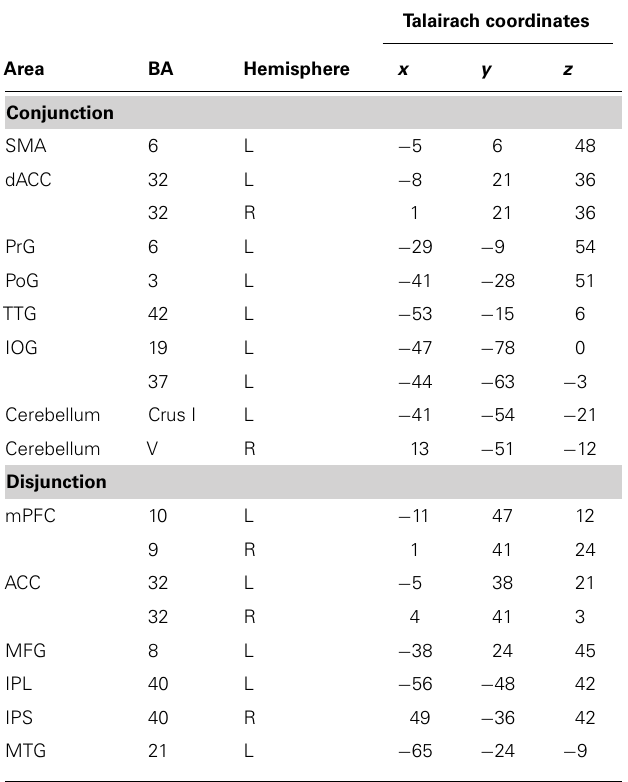
Table 3 | Coordinates of conjunction and disjunction of brain activation correlates of contour in authenticity task trials of study 1 and emotion task trials of study 2.